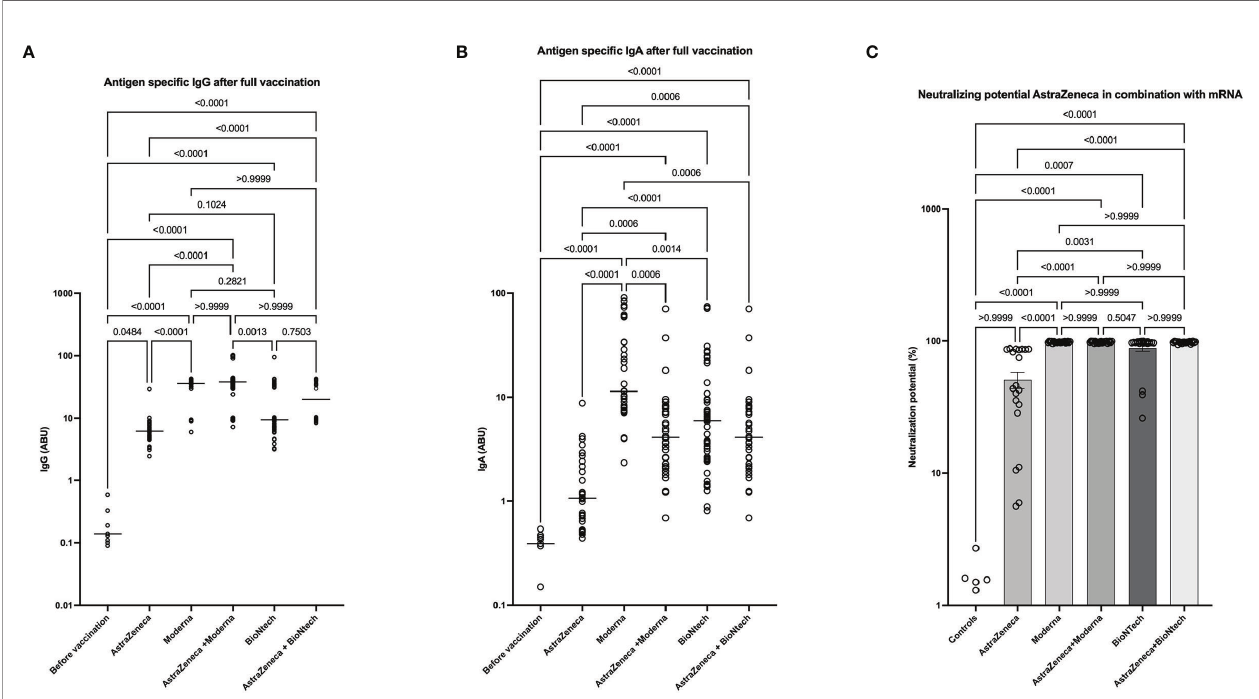
FIGURE 6 | High neutralizing antibody expression in AstraZeneca- mRNA vaccine combinations. Graphs represent the expression of SARS-CoV-2 speci fi c spike- protein binding IgG (A) , IgA (B) , and neutralizing antibody expression (C) observed in the sera of people that received homologous (AstraZeneca, Moderna, or BioNTech) ‘ s COVID-19 vaccines or heterologous vaccine doses (AstraZeneca-Moderna or AstraZeneca-BioNTech). Each symbol represents individual donors. Indicated p values were calculated using Kruskal-Wallis ‘ test followed by Dunn ’ s comparison post hoc to compare all groups. Bars represent the median (A, B) of SARS-CoV-2 spike protein-speci fi c antibody expression in each group in arbitrary binding units (ABU) or the means ± SEM percentages of relative neutralizing antibody expression (C) . Signi fi cance is accepted if p